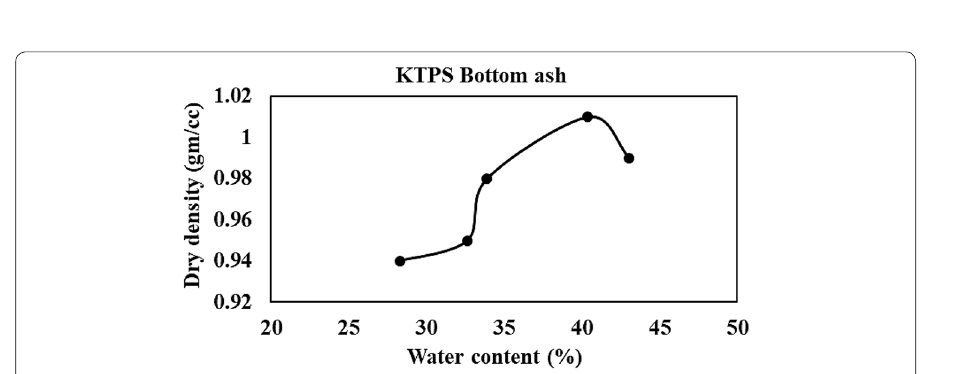
Fig. 15 Compaction curve for KTPS bottom ash